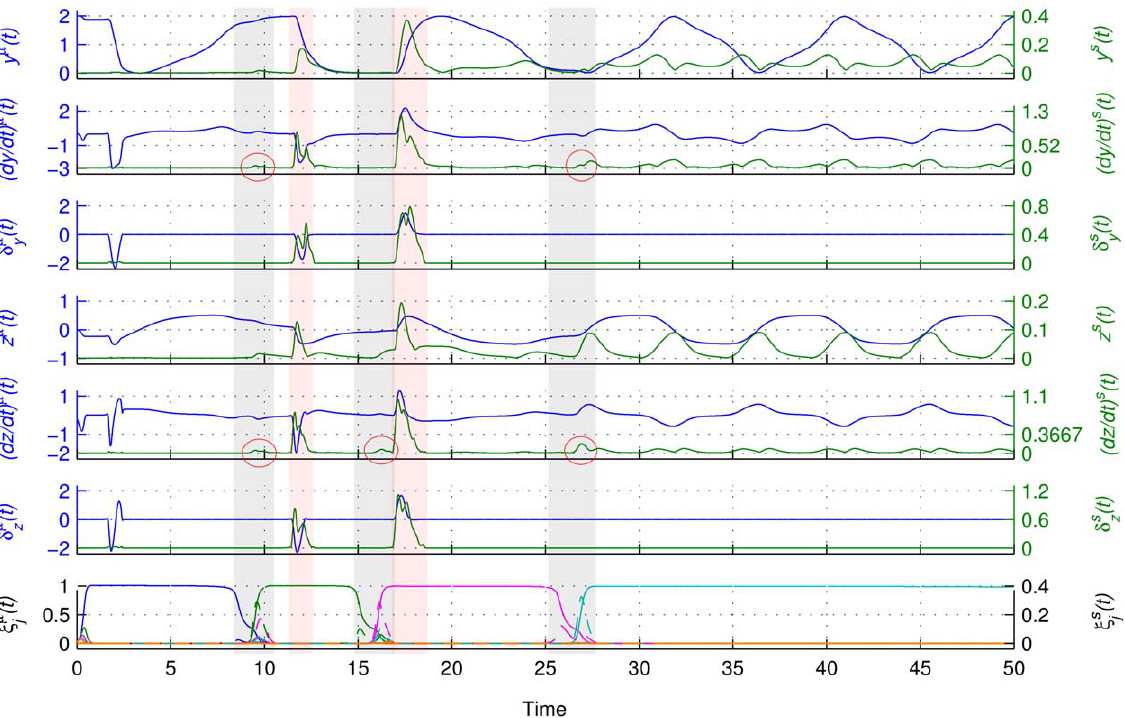
Figure 6. Time series analysis. From top to bottom: means and standard deviations of y ( t ) (denoted as y m ( t ) and y s ( t )) of dy ( t )/ dt (( dy / dt ) m ( t ), and ( dy / dt ) s ( t )), of d y ( t ) ( d y m ( t ) and d ys ( t )), of z ( t ) ( z m ( t ) and z s ( t )) of dz ( t )/ dt (( dz / dt ) m ( t ), and ( dz / dt ) s ( t )), of d z ( t ) ( d z m ( t ) and d zs ( t )), and of { j j ( t )} ( j j m ( t ) and j j s ( t )). Means are plotted in blue and standard deviations in green except for the graph of { j j ( t )} where colors correspond to different modes and where means and standard deviations are plotted with a continuous and dashed line, respectively. Grey and pink shadings focus on the segments of increased { j j ( t )} and d y , z ( t ) variability, respectively. Notice the strong effect of d -‘kicks’ on the means and standard deviations of the state variables’ rates of change (( dy / dt ) m ( t ), dz / dt ) m ( t ) and ( dy / dt ) s ( t ), ( dz / dt ) s ( t )). Instead, the variability of { j j ( t )} ( j js ( t )) has a much weaker effect on ( dy / dt ) s ( t ) and ( dz / dt ) s ( t ), and cannot be unambiguously distinguished from the rest of the ( dy / dt ) s ( t ) and ( dz / dt ) s ( t ) variability.